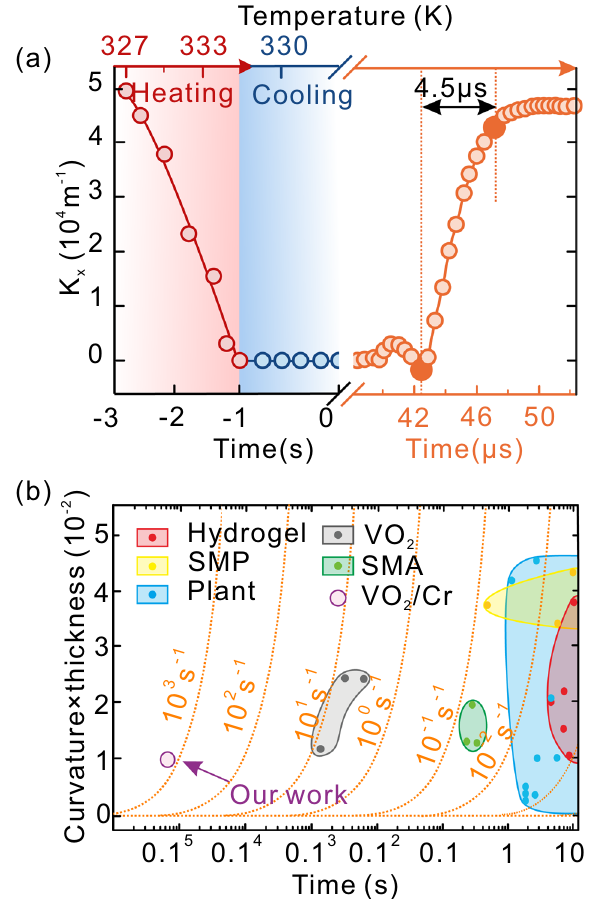
Fig. 3 Dynamic characteristic of Gaussian-preserved shape morphing. a Curvature in x -direction as a function of temperature varied with time. Red and blue circles present heating and cooling processes, respectively, indicating the shape-shifting process from the rolled shape ( K x = 5×10 4 m − 1 ) to the folded shape ( K x = 0). The orange circles present the shape-shifting process within 4.5 μ s from folded shape to rolled shape triggered by mechanical stimuli. b Actuation speed, orange dashed line, and relative curvature change of membrane-based actuators in the literature and our